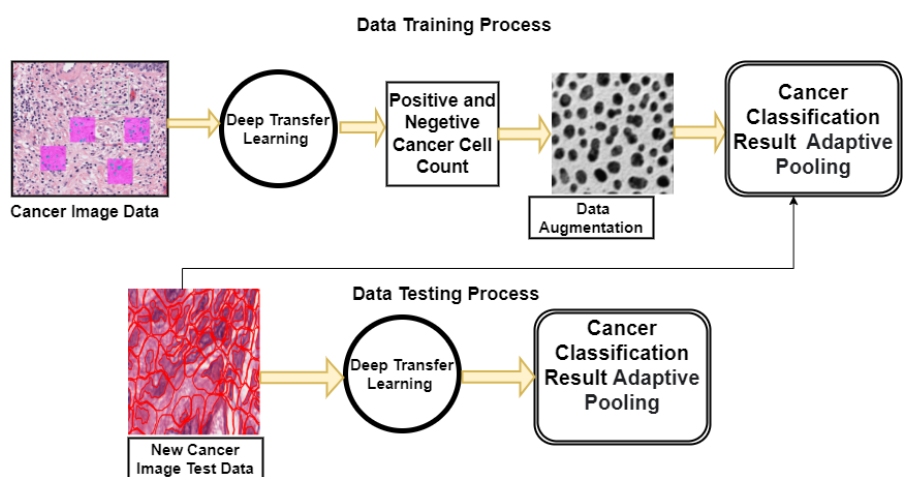
Figure 1. The proposed deep transfer learning